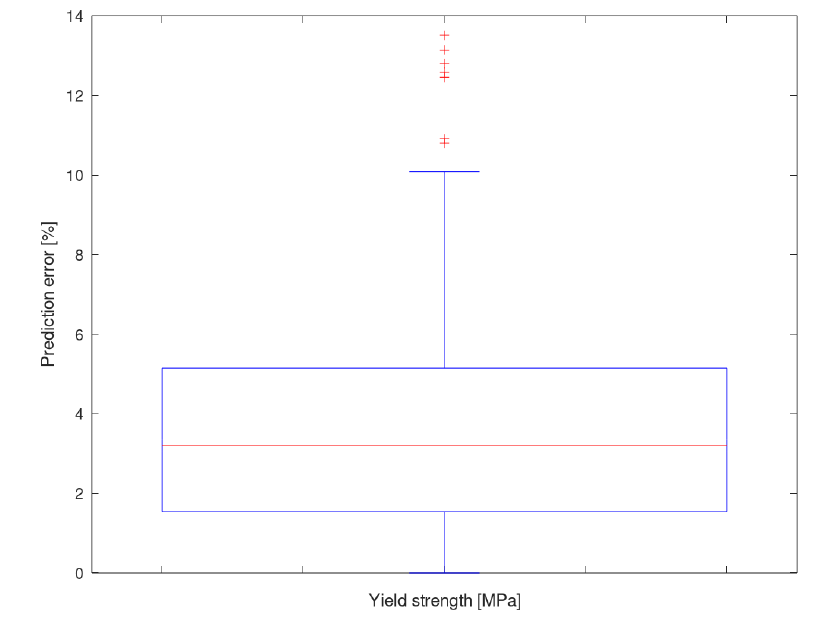
Figure 7. Prediction deviation of the yield strength for all iterations.